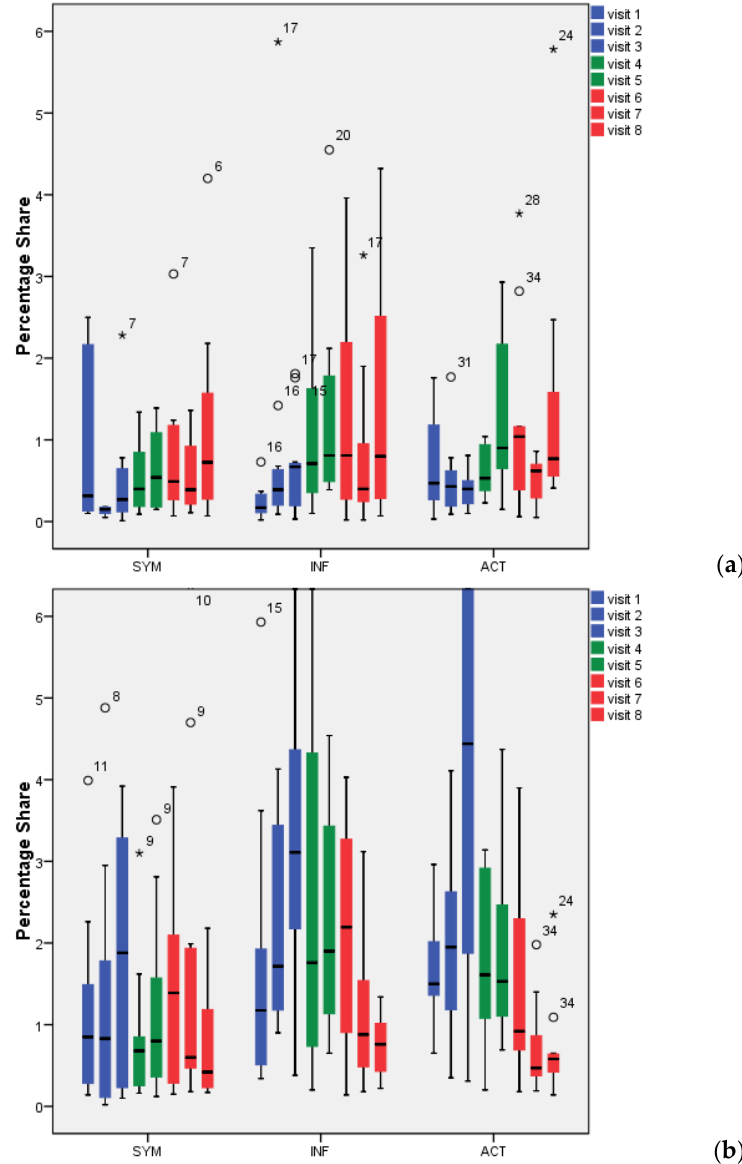
Figure 2. Percentage of lactobacilli/ Enterococcus faecalis in 72-h dental biofilm ( a ) and saliva ( b ). °: Outliers with values between 1.5 and 3 times the interquartile range (IQR) above the 75%-quantile (Q3) (Q3 + 1.5 × IQR ≤ value ≤ Q3 + 3 × IQR); *: Extremes with values more than 3 times the IQR higher than Q3 (value > Q3 + 3 × IQR).